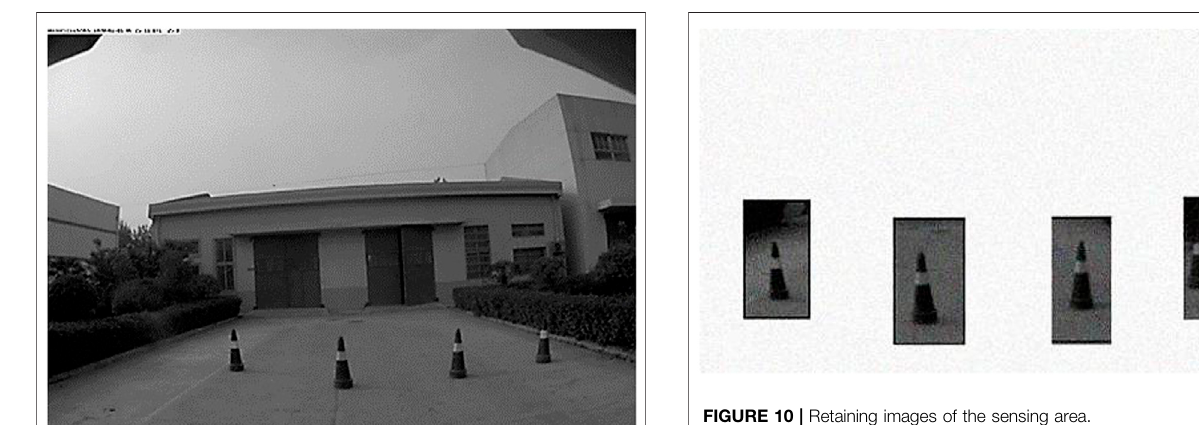
FIGURE 10 | Retaining images of the sensing area.